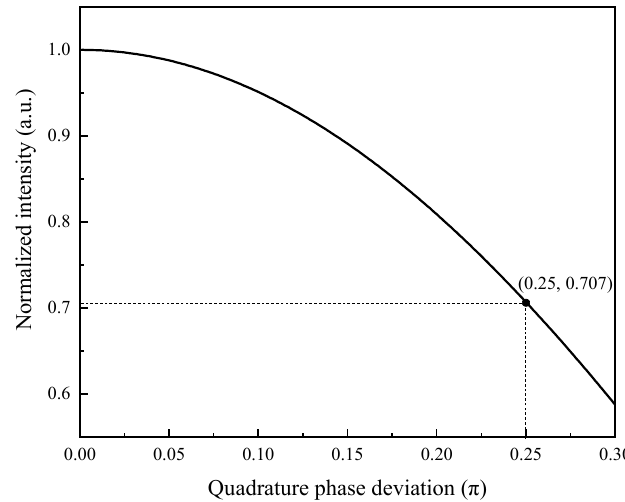
Figure 7. Demodulated signal intensity versus quadrature phase deviation curve.